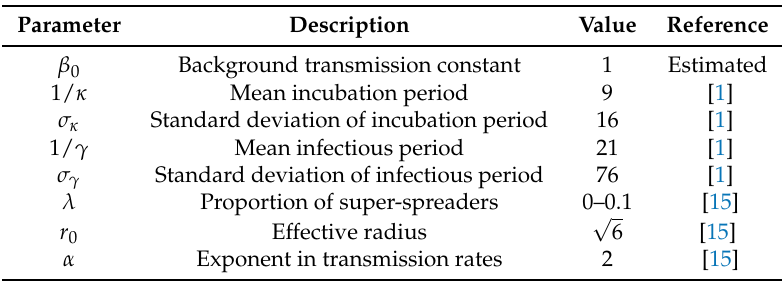
Table 1. Baseline parameter